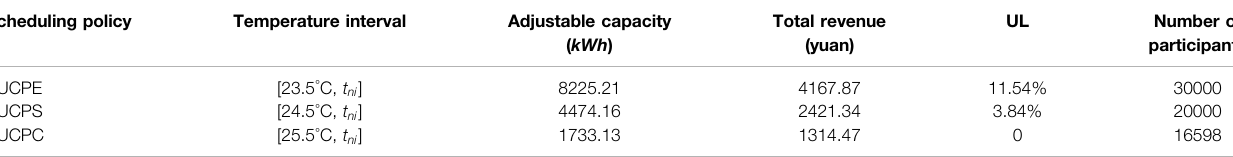
TABLE 3 | Dispatching capacity in 1 hour regardless of SLs ’